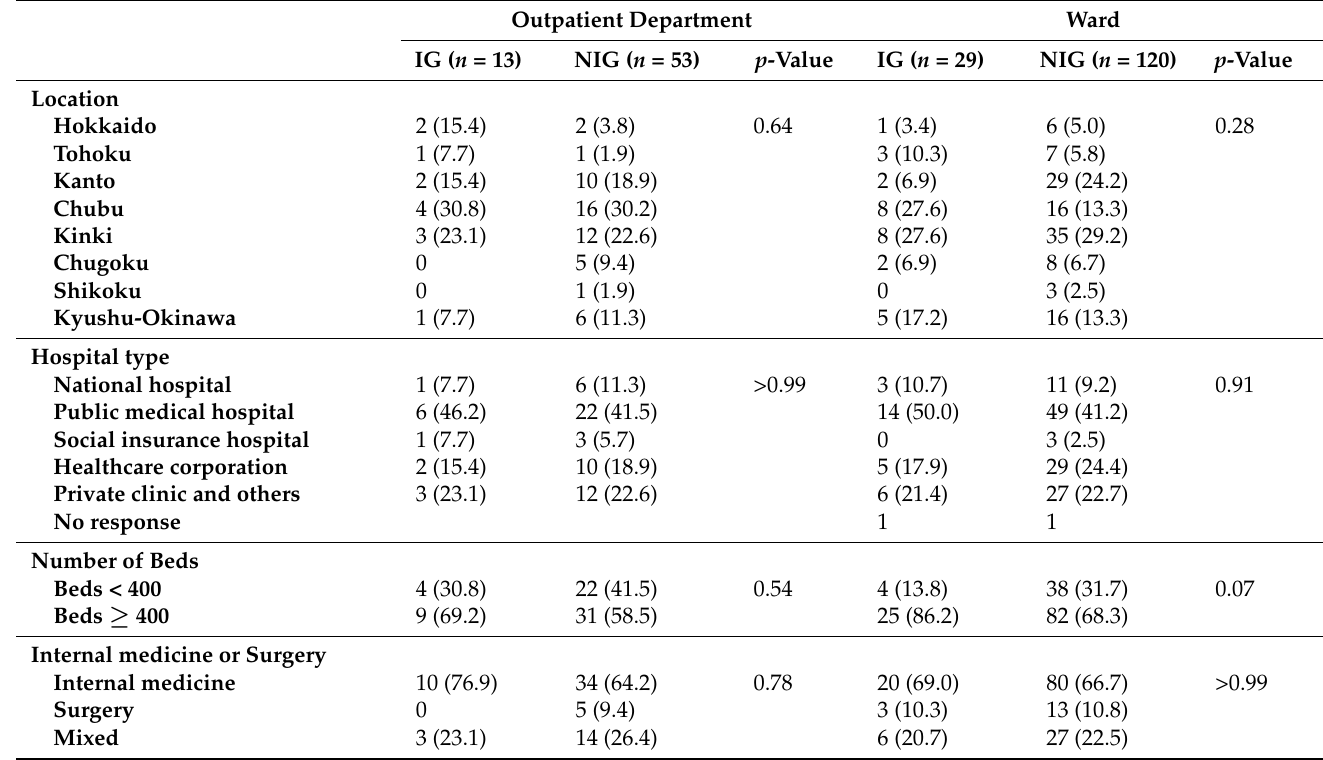
Table 5. Comparison between intervention group and non-intervention group in outpatient department and